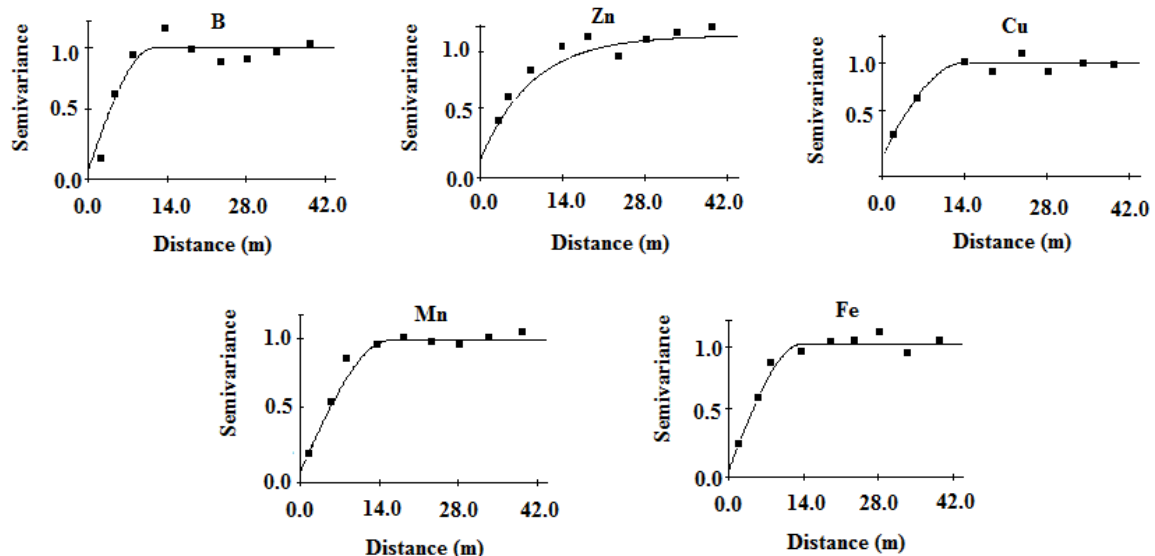
Figure 5. Standardized theoretical semivariograms for leaf micronutrients (B, Zn, Cu, Mn and